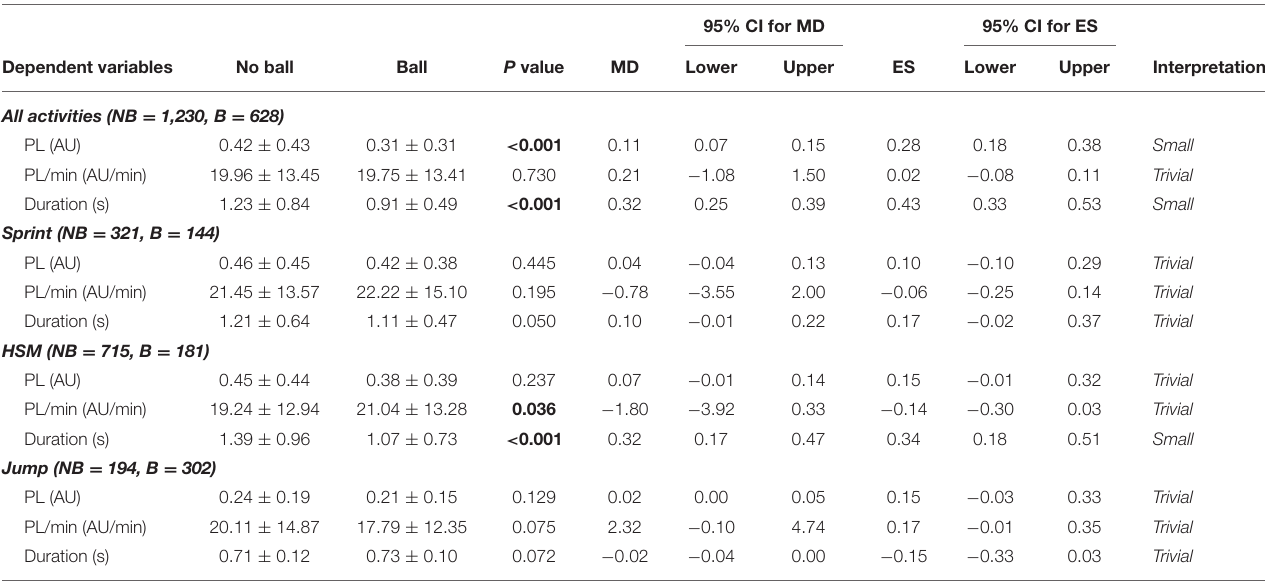
TABLE 4 | Differences in PL, PL/min and duration for activities with and without